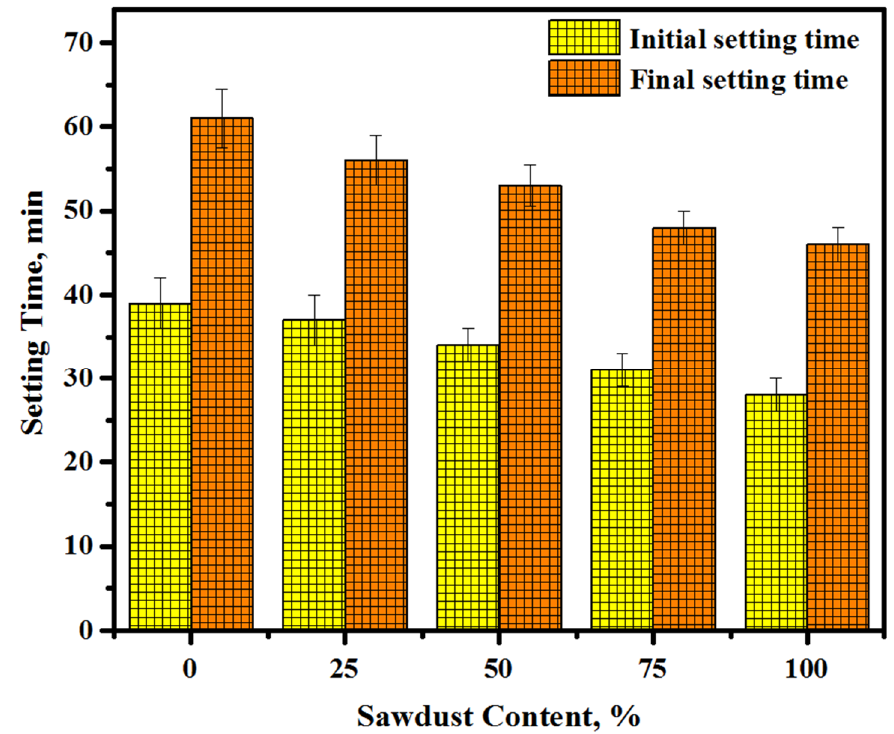
Figure 6. E ff ect of the sawdust content on the concretes’ initial and final setting Figure 6. Effect of the sawdust content on the concretes’ initial and final setting times.